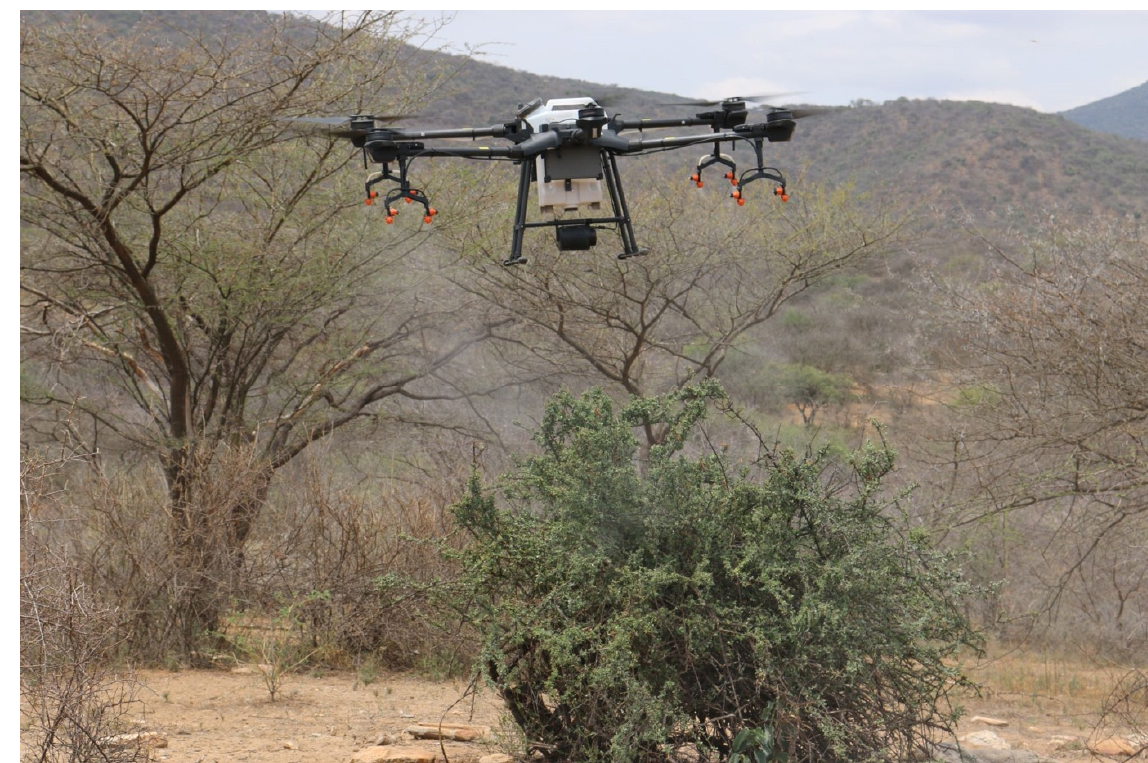
Figure 3. Drone spraying locusts in trees in Kenya (source: CABI [33]).